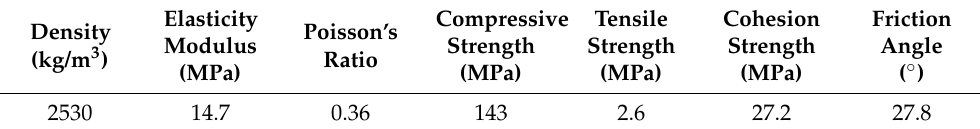
Table 3. Parameters of sedimentary gravel materials. Figure 9. Model meshing and encryption of drill-pipe gravel contact area.